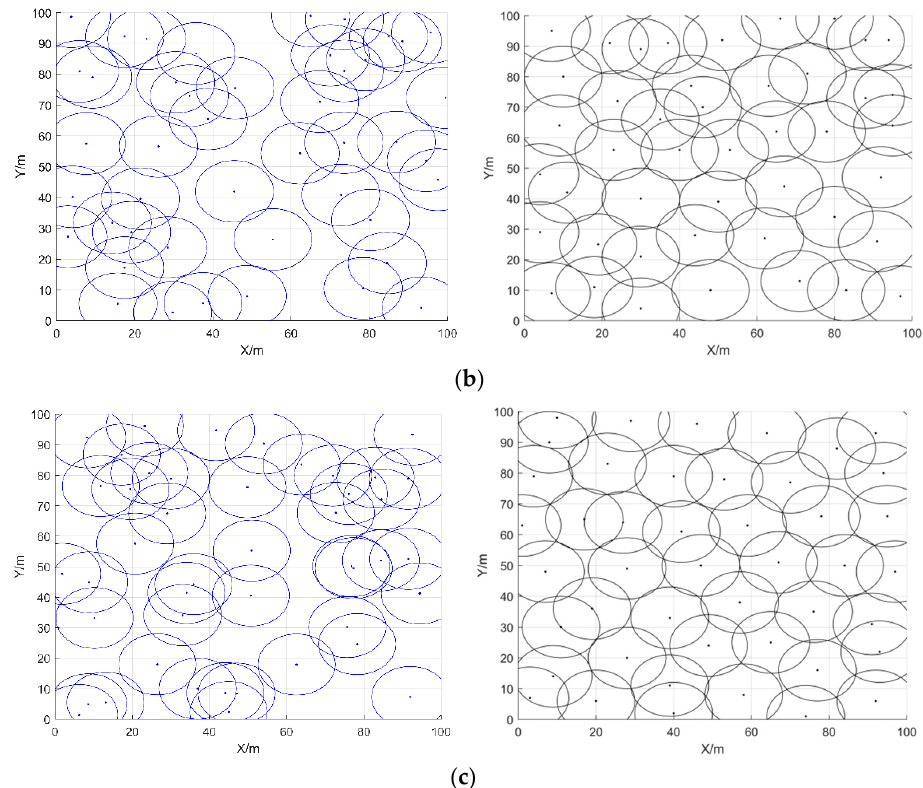
Figure 17. Initial coverage diagram and coverage optimization diagram of COOTCLCO in three cases: ( a ) q = 45, Rs = 10 m, Iteration = 500; ( b ) q = 45, Rs = 10 m, Iteration = 1000; ( c ) q = 45, Rs = 10 m, Iteration = 1500.